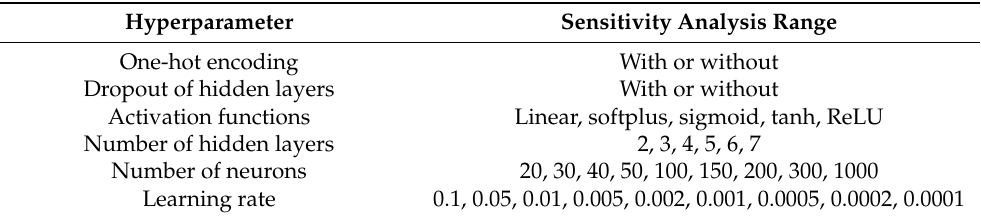
Table 8. Hyperparameter sensitivity analysis range of DNN model.